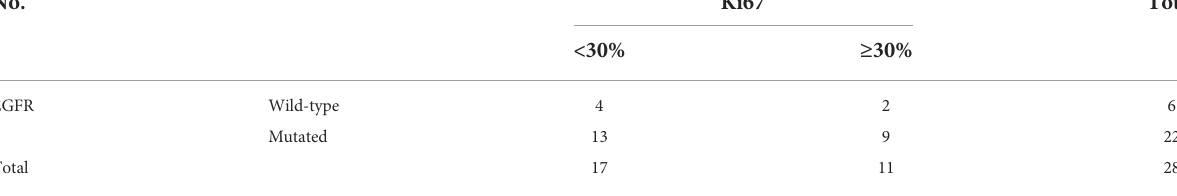
TABLE 2D Correlation of EGFR mutation and Ki67 expression of breast cancer.